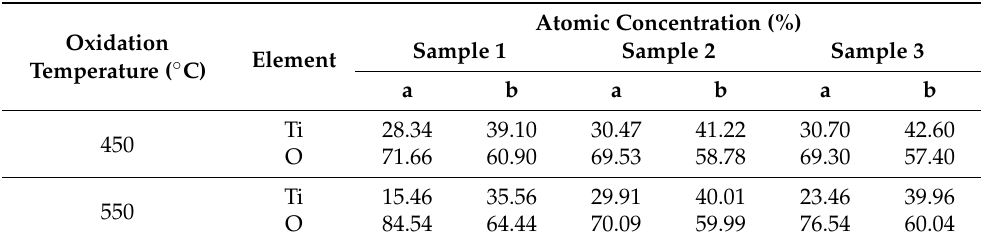
Table 2. Chemical composition of the Ti-TiO 2 bilayer thin-film surface and internal area with different samples oxidized for 3 h.